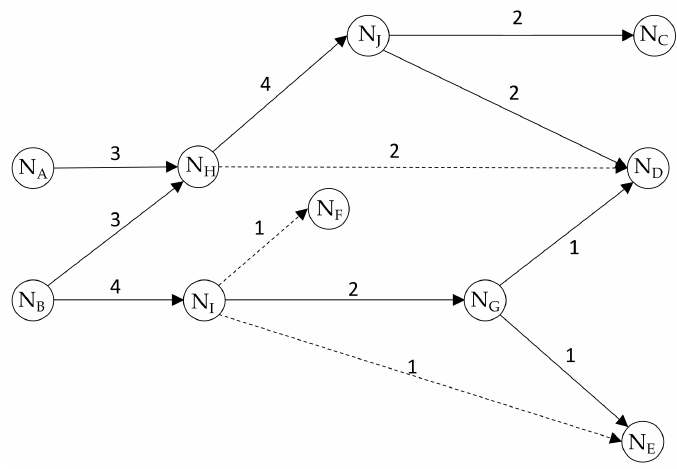
Figure 2. Main paths of the example network. Source: Adapted from